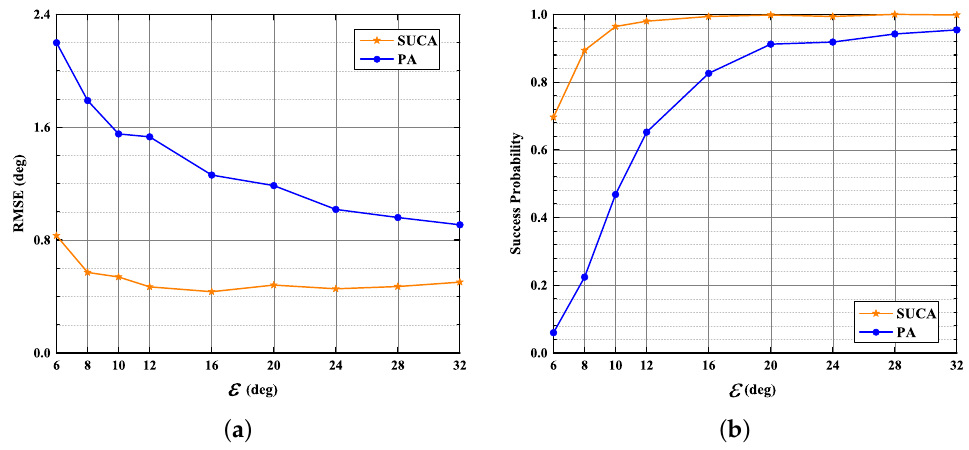
Figure 11. RMSE, Success Probability versus ε , K = 1024, SNR = 10 dB: ( a ) RMSE versus ε ; ( b ) Success Probability versus ε .